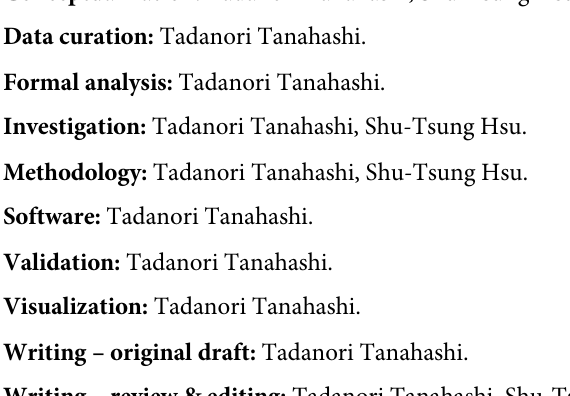
S2 Fig. Interconnector ribbons exposed using a micro-grinder (a) and the attached electrical leads